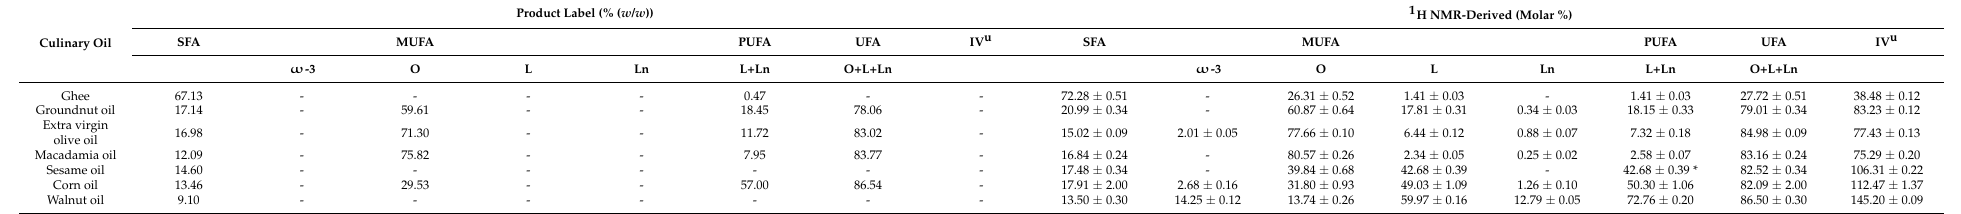
Table 1. A comparison between product-label and 1 H NMR-investigation of FA groups and IVs of culinary